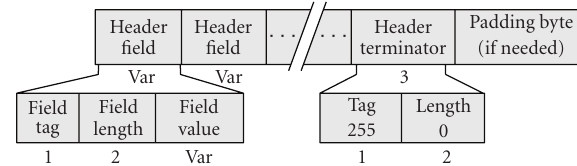
Figure 5: Overview of the data part holding the allergy data (Section-204).